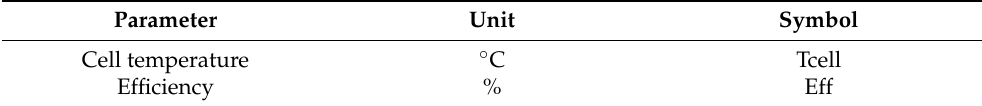
Table 3. Two additional